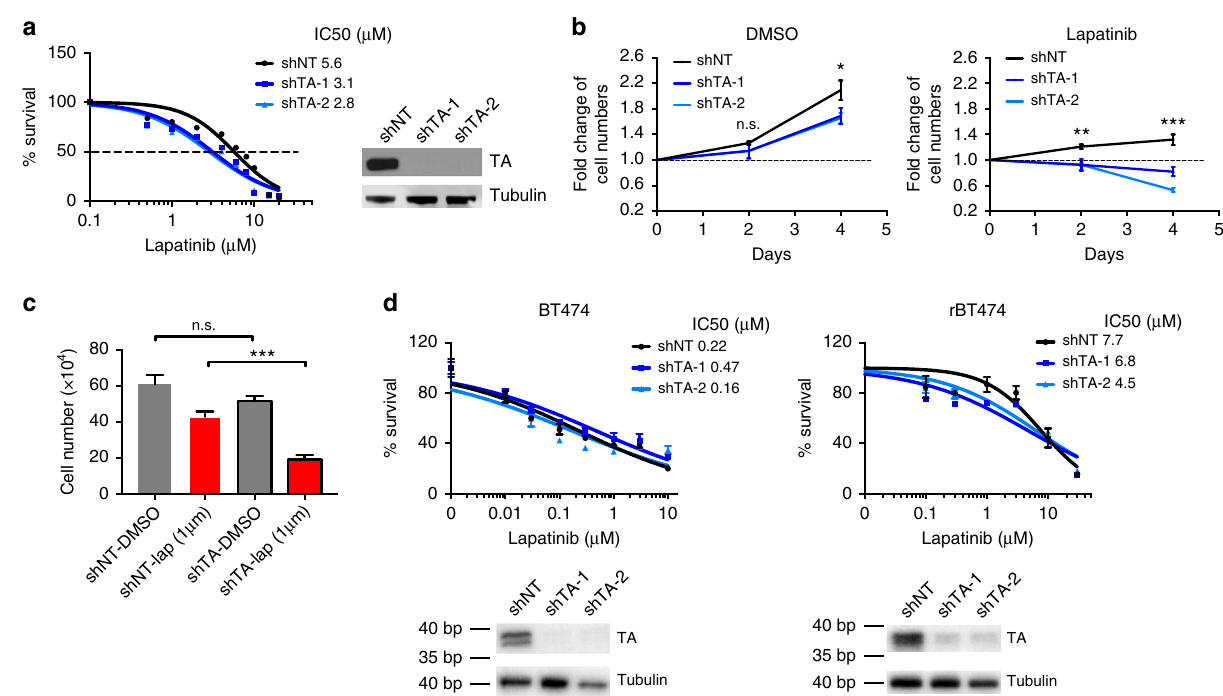
Fig. 2 TA mediates sensitivity to lapatinib in intrinsically resistant breast cancer cells. a Dose – response curves of MDA-MB-361 cells carrying shNT or shTA constructs. ( n = 4). Western blot showing shRNA knockdown ef fi ciency. b Fold change of cell numbers at the indicated time points in shNT or shTA cells treated with DMSO or 4 μ M lapatinib ( n = 3). c Numbers of MDA-MB-453 cells cultured with DMSO or 1 μ M lapatinib for 3 days and co-treated with either shNT or shTA ( n = 3). d Dose-response curves of BT474 and rBT474 cells carrying shNT or shTA constructs ( n = 4). Western blot showing shRNA knockdown ef fi ciency. IC50s were calculated using Prism curve fi t (variable slope) default program. Error bars denote the SD; n.s., not signi fi cant; * P < 0.05; ** P < 0.005; *** P < 0.001 by unpaired, two-tail, student t